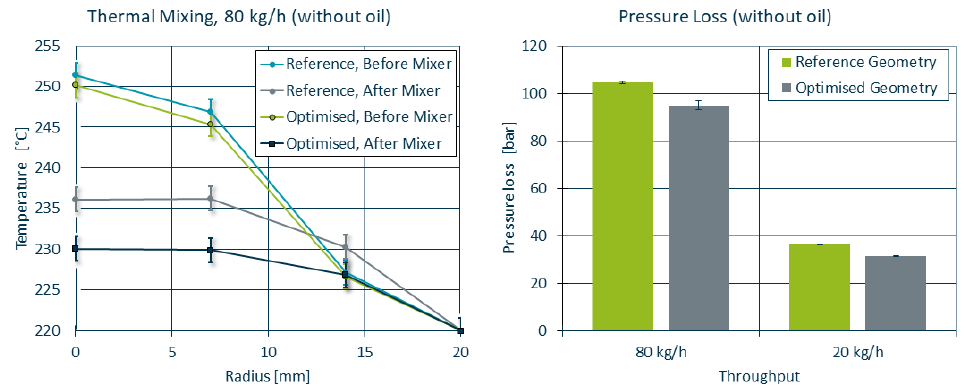
Figure 11. Thermal homogenisation and pressure loss of the reference and optimised mixer geome- tries. Note that the error bars in the temperature curves refer to the uncertainties in the temperature sensors as they outweigh the standard deviations in the recorded